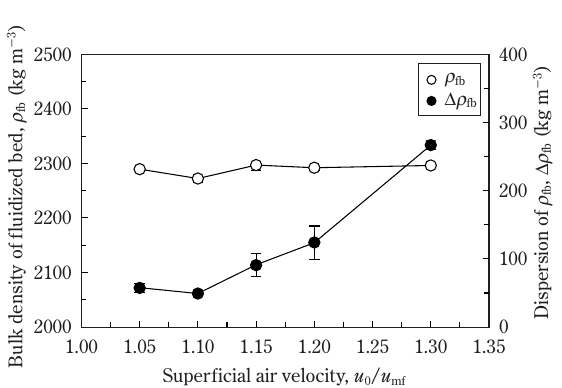
Fig. 7 Dependence of fluidized bed bulk density and its dispersion on superficial air velocity. Powder is